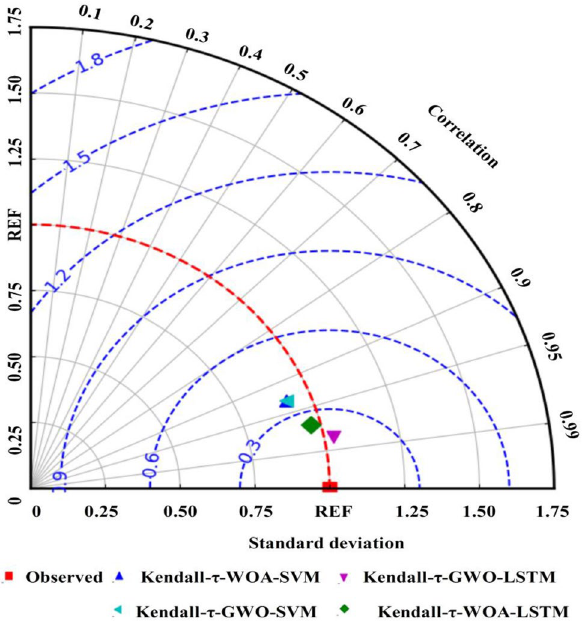
Figure 6. Taylor diagrams of the hybrid Kendall-τ-WOA-SVM, Kendall-τ-GWO-SVM, and Ksendall-τ-WOA- LSTM models with optimal hyper-parameters and input combinations.